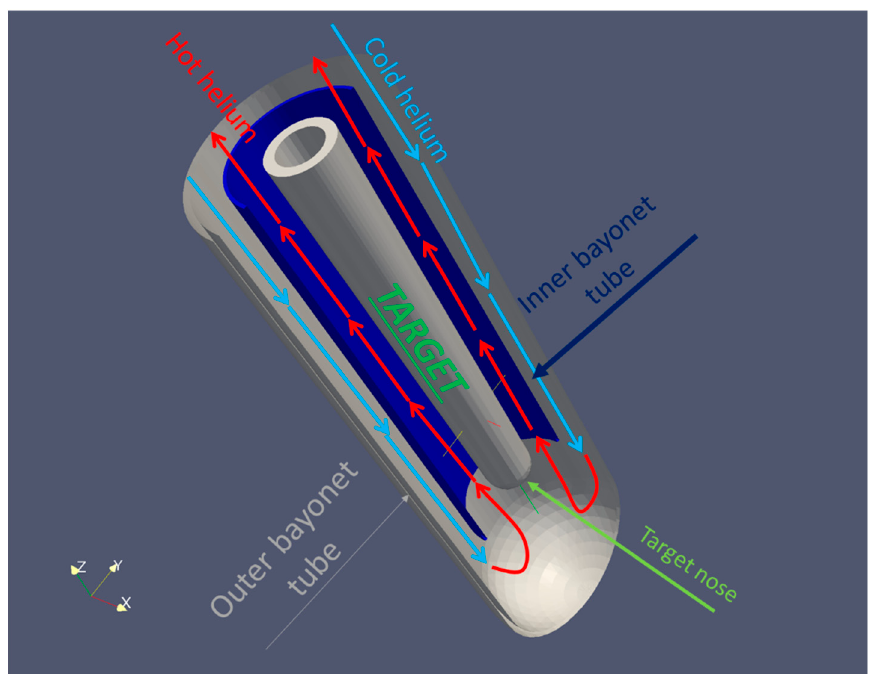
Figure 2. Target Bayonet tube scheme of operation.